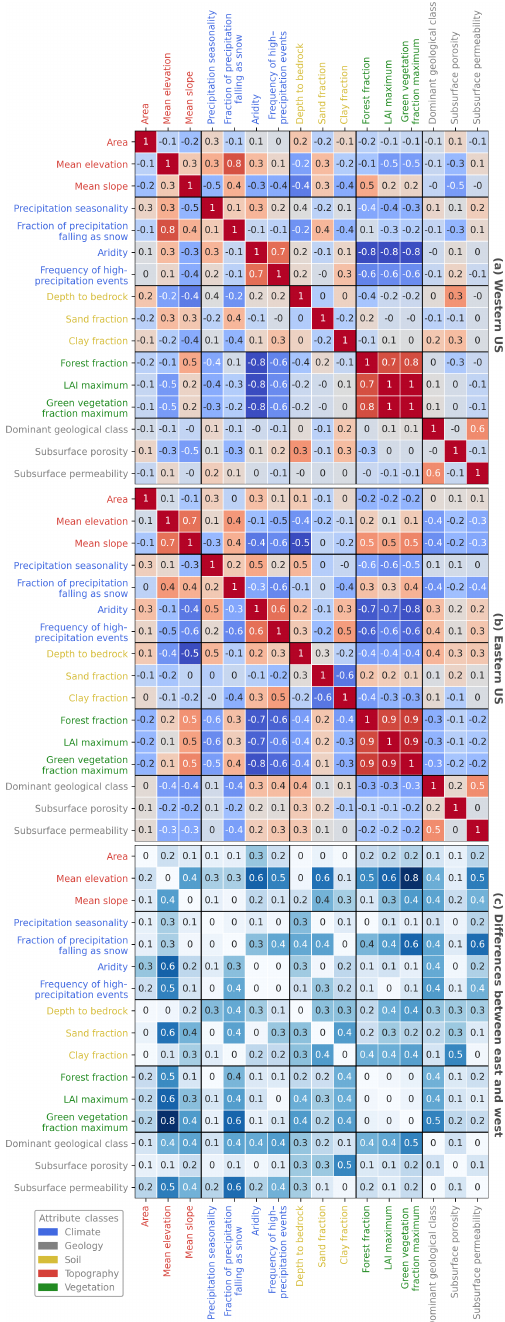
Figure 1. Spearman rank correlation coefficients given for all catch- ment attributes in the western (a) and eastern (b) US. Absolute differences of the correlation coefficients between the eastern and western US are given in (c) . Eastern and western is defined by the 100th meridian. Due to rounding effects, correlations with the same Spearman rank correlation coefficient might show slightly varying color